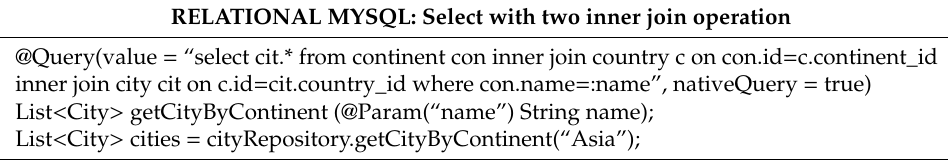
Table 6. Complex select with two inner join operations.